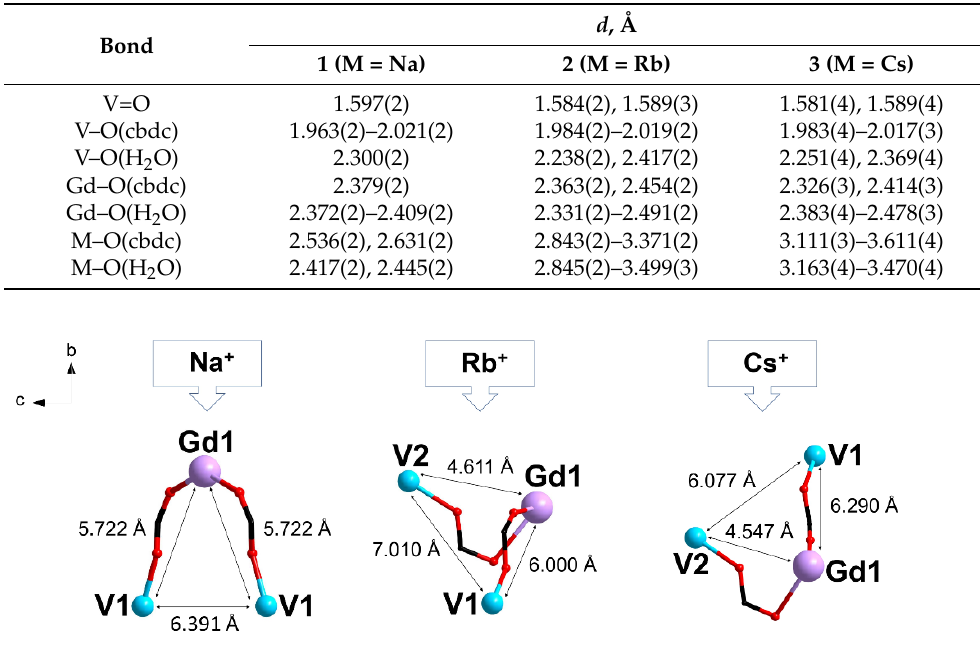
Figure 7. Effect of the alkali metal cation M + on the structure of the trinuclear anion {GdV 2 } – and the V···Gd, V···V distances in compounds 1 – 3